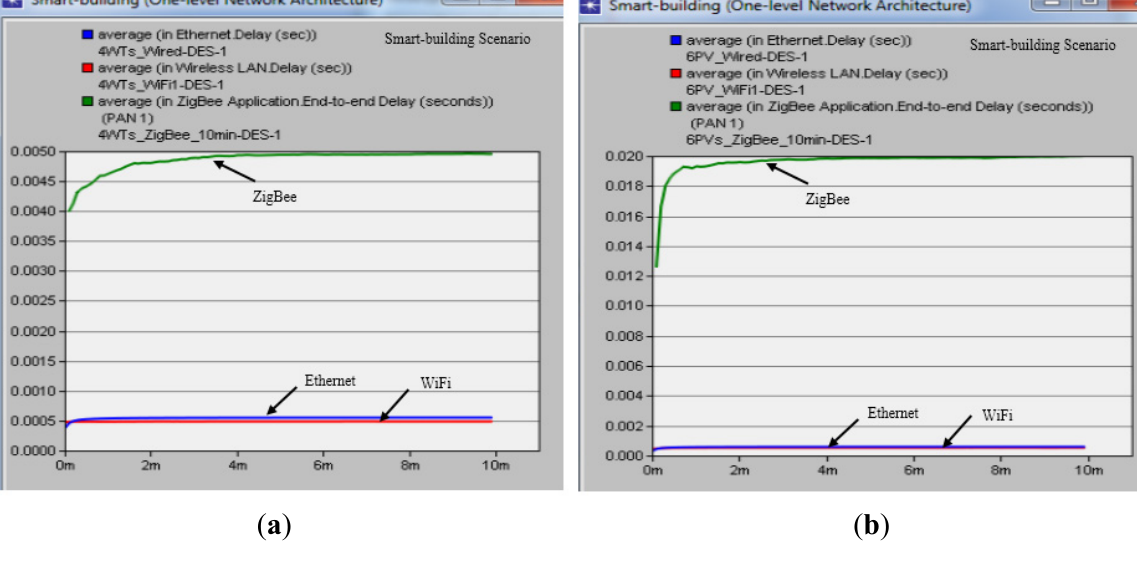
Figure 13. Average ETE delay for the smart-building scenario. ( a ) Four WTs; ( b ) Six PVs. Table 9. Simulation results of the smart-building. (one-level network